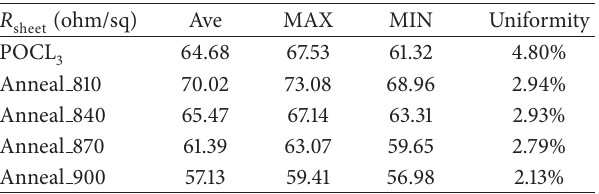
Table 2: Comparison of 𝑅 diffusion and 4 different anneal processes.